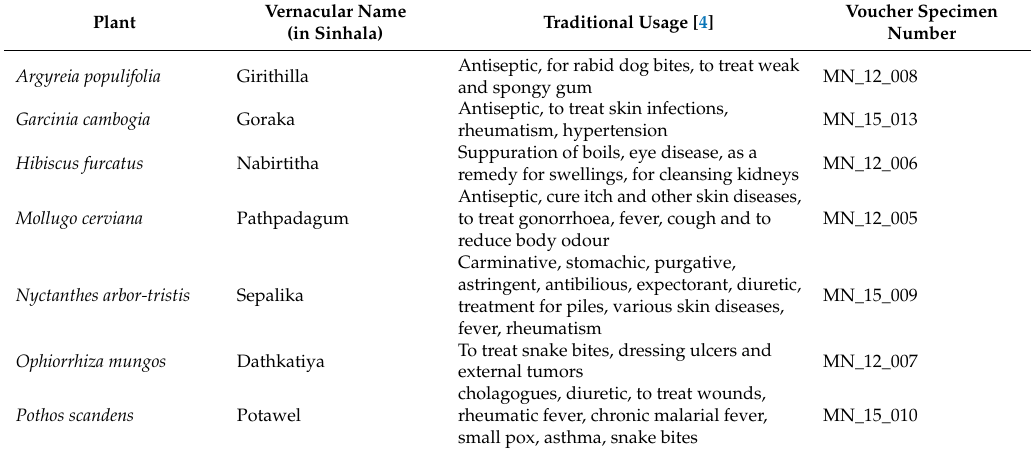
Table A1. The traditional uses of the plant species investigated in the present study.